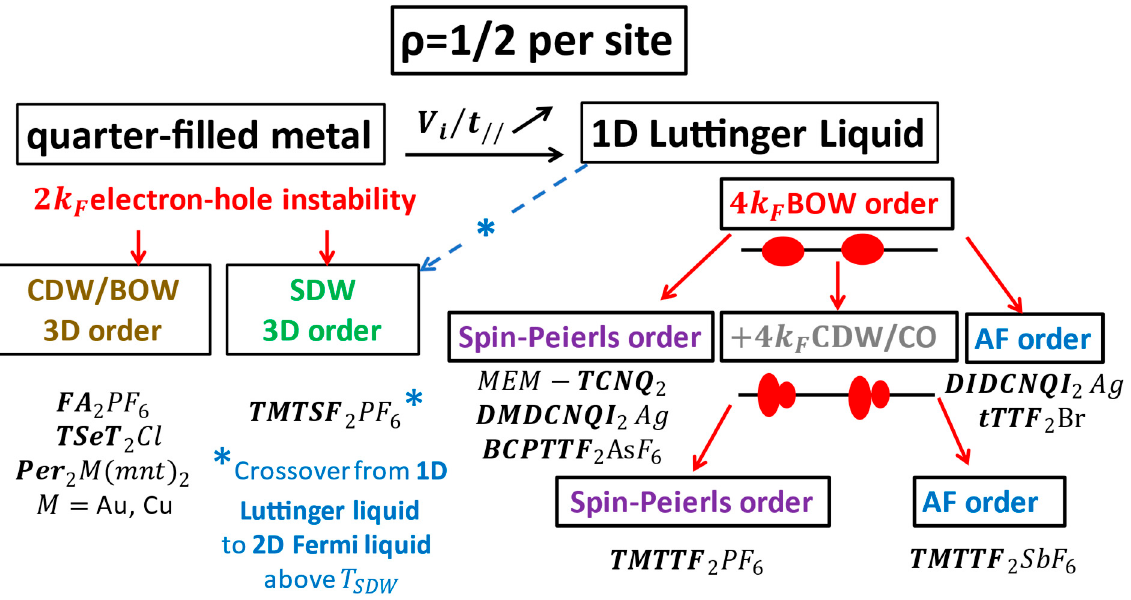
Figure 2. Electronic phase diagram of the quarter-filled chain. The various electronic instabilities and ground states are schematically described. Typical experimental examples are also indicated. The stack bearing the instability is in bold text. The crossover from a 1D Luttinger liquid to a 2D Fermi liquid in TMTSF 2 PF 6 is indicated by the symbol * in the figure.